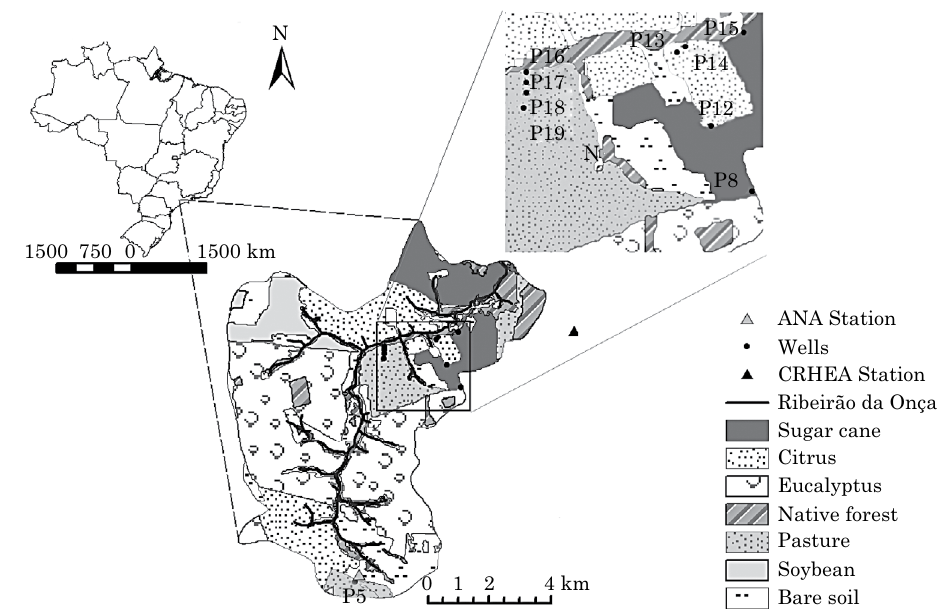
figure 1. location of the ribeirão da onça watershed, monitored wells and land use in the study area in 2011, locations of the rainfall station ana and weather station crhEa. adapted from manzione et al.